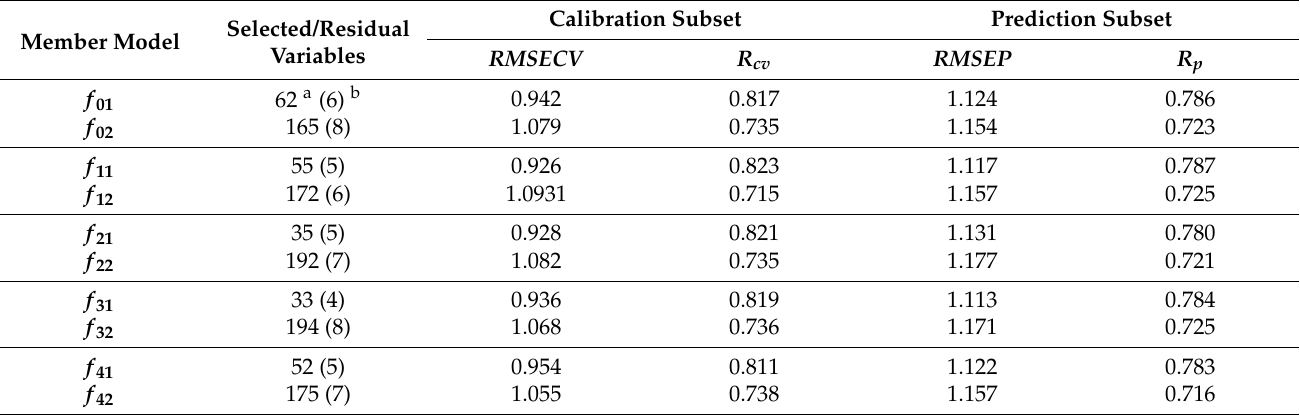
Table 3. Predictive performance of PLS models by genetic algorithm